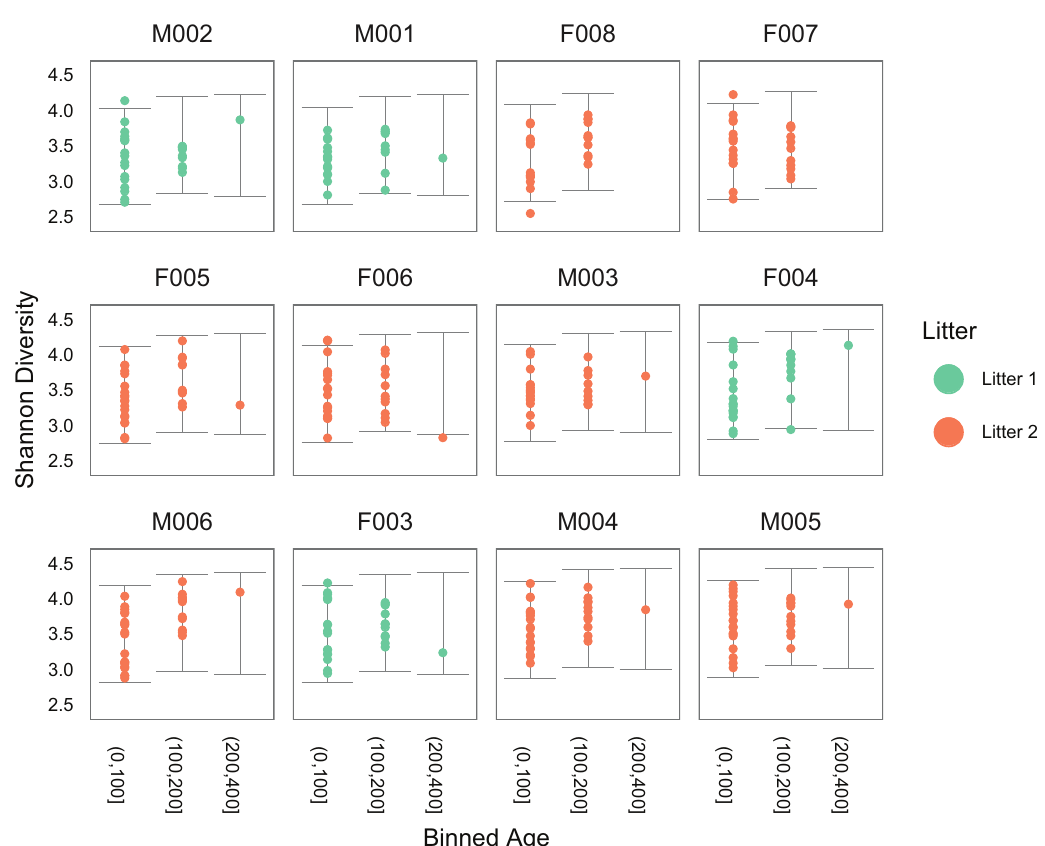
Figure 26. Each point represents the Shannon diversity at one timepoint for a mouse; each panel is a different mouse. The timepoints have been split into three bins, according to the mices’ age. The prediction intervals obtained from mixed-effects modeling are